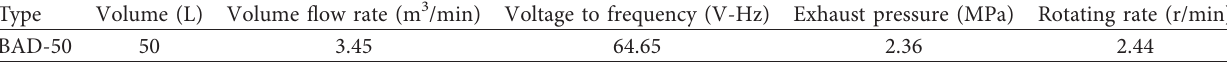
Table 1: Technical parameters of the air compressor.